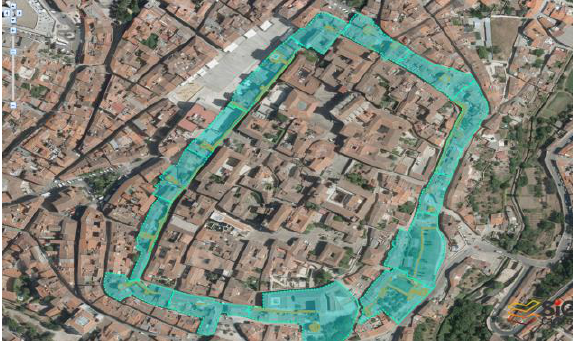
Figure 2. Walled city of Cáceres. Scope of original wall. Source: © SPOT Image Copyright 2019, SIG of Cáceres